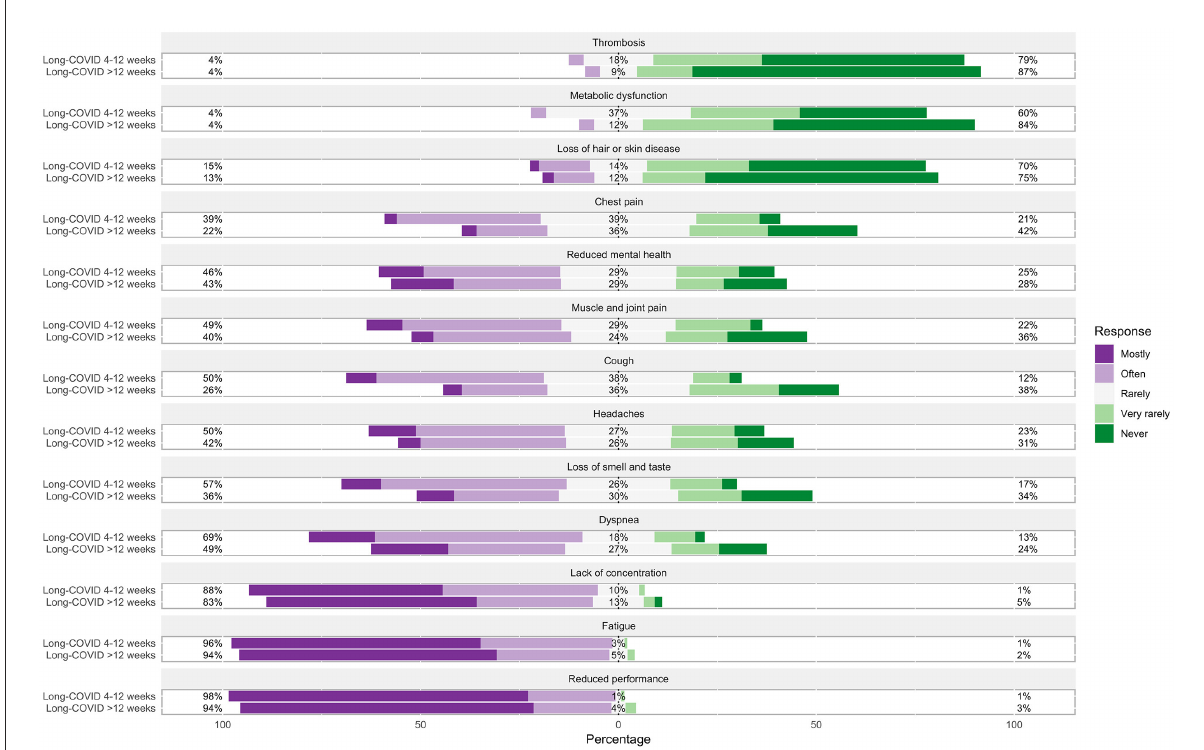
FIGURE3 Frequencies of each observed symptom in patients with long COVID symptoms lasting between 4 and 12 weeks and lasting more than 12 weeks in the general practice. Percentages on the left and right side of the graph represent a summary of mostly and often on the left and very rarely and never on the right